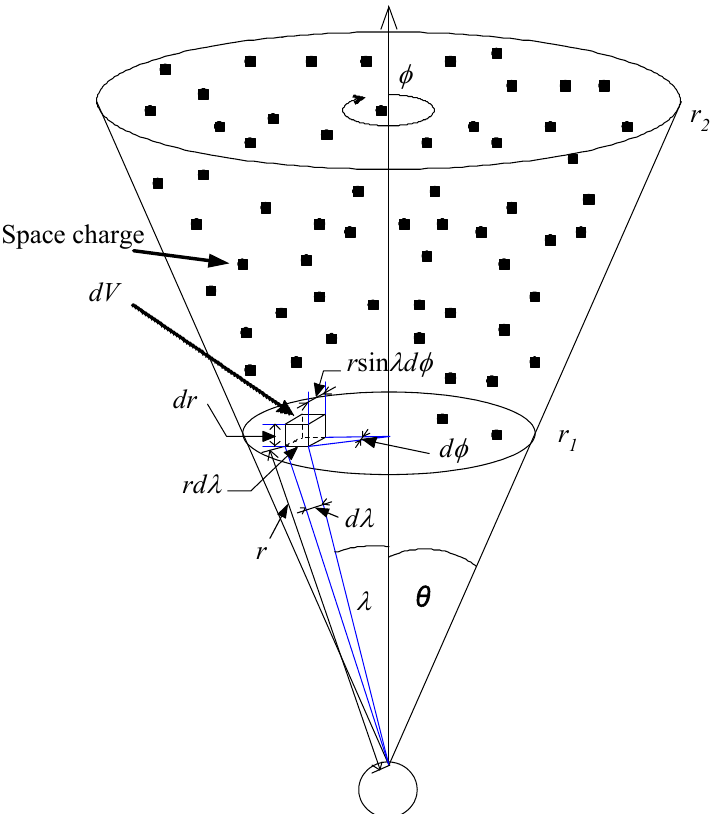
Figure A1 . An illustration of propagation of the sound wave to the